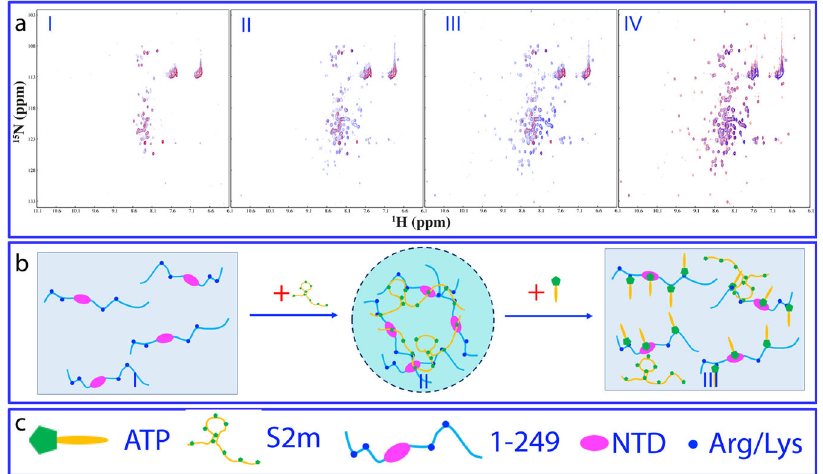
Fig. 6 NMR view of the interplay of ATP and S2m in modulating LLPS of N (1-249). a Superimposition of HSQC spectra of N (1-249) in the presence of S2m at 1:0.75 (red) with additional addition of ATP (blue) at 5 mM (I), 10 mM (II) and 20 mM (III). (IV) Superimposition of HSQC spectra of N (1-249) in the presence of ATP at 10 mM only (red) and in the presence of both S2m at 1:0.75 and ATP at 20 mM (blue). b Speculative model of N (1-249) in homogeneous solution (I) which undergoes phase separation to form dynamic liquid droplets upon induction by S2m (II), followed by dissolution of droplets into homogeneous solution upon adding the exceeding amount of ATP (III). c Illustration